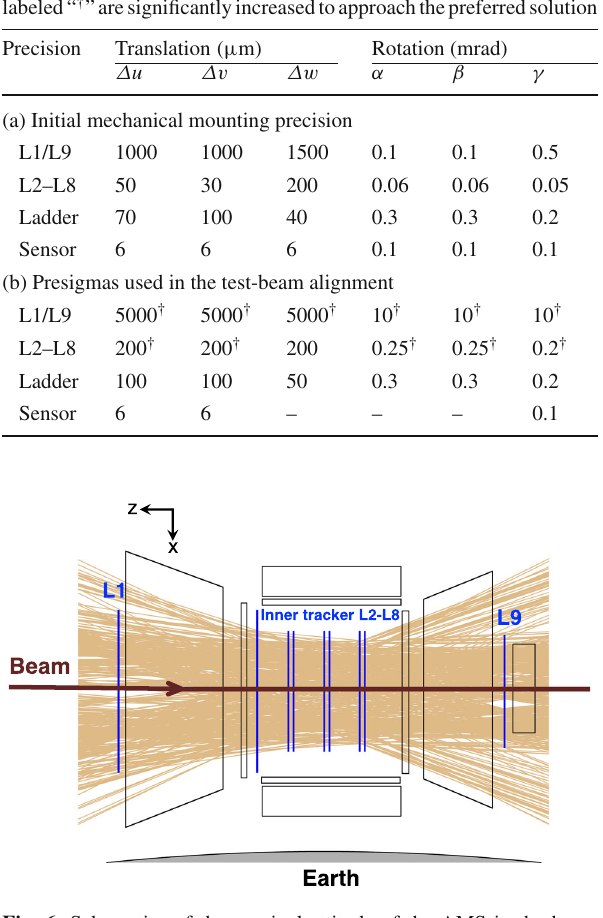
Table 1 a The initial mechanical mounting precision of the tracker modules and b the presigmas of the alignment parameters used in the